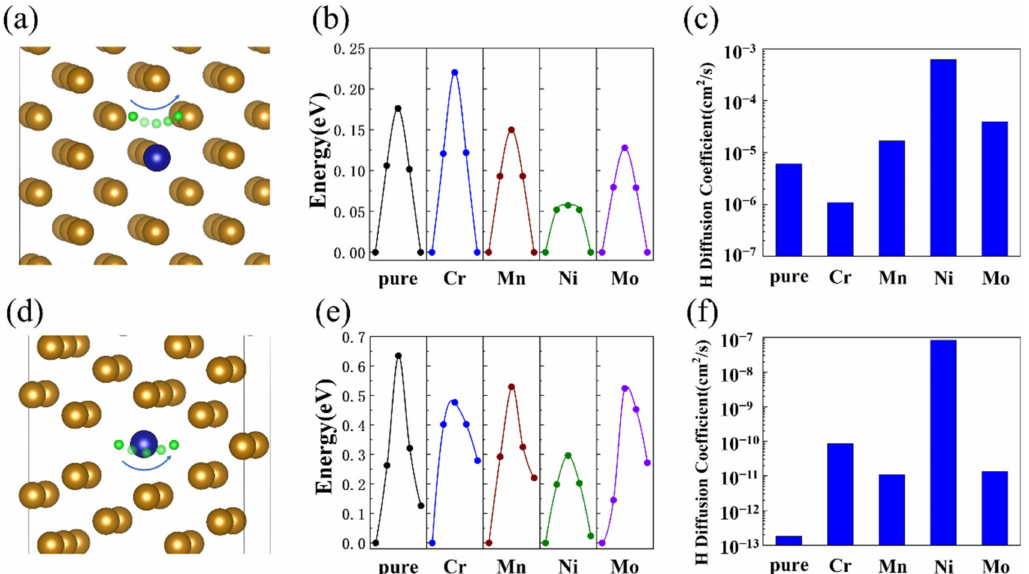
Figure 5. ( a ) hydrogen diffusion in doped bcc-Fe bulk structure, ( b ) H diffusion barriers of doped bcc- Fe bulk structure, ( c ) H diffusion coefficients of doped bcc-Fe bulk structure, ( d ) hydrogen diffusion in doped bcc-Fe Σ 5 GB, ( e ) H diffusion barriers of doped bcc-Fe Σ 5 GB, ( f ) H diffusion coefficients of doped bcc-Fe Σ 5